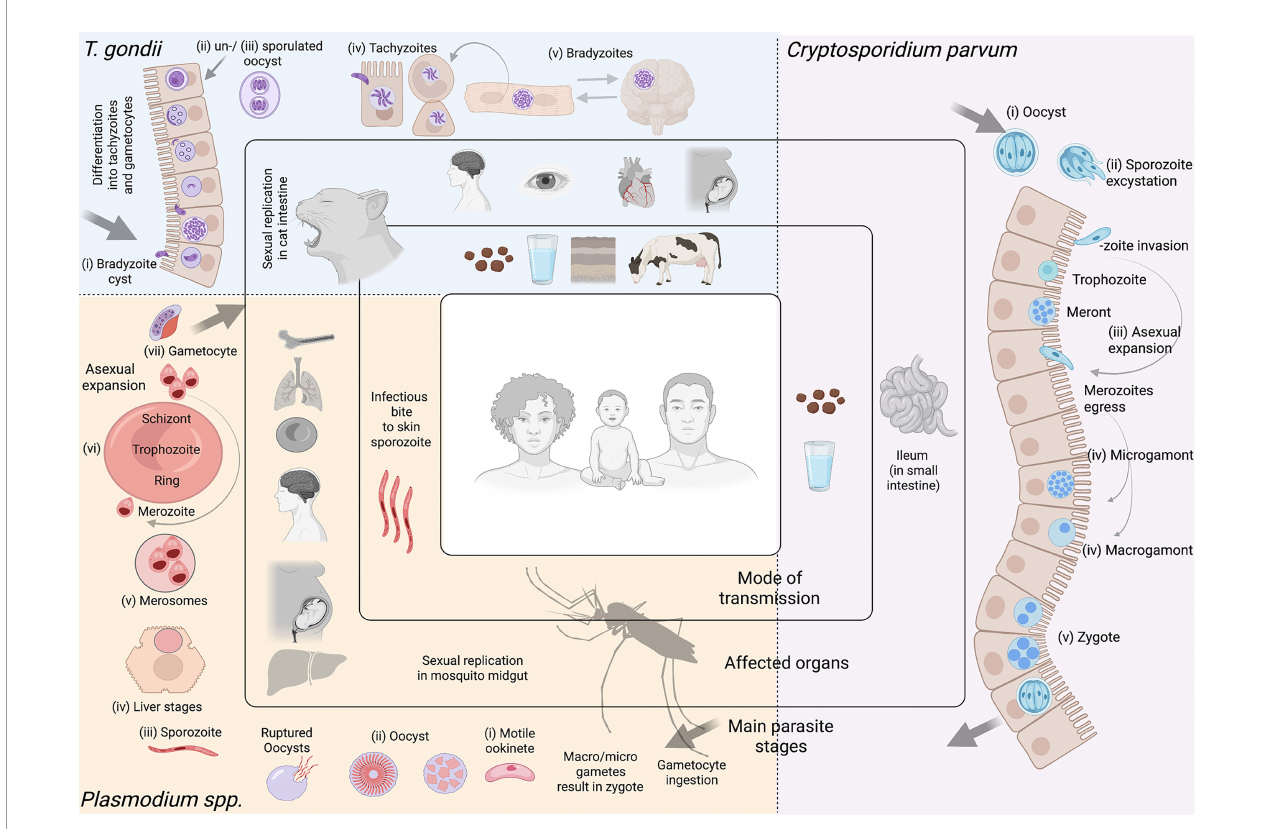
FIGURE 1 | Apicomplexan parasites. Most apicomplexan parasites have complex life cycles with several developmental stages that occur in different hosts and in different organs or tissues within the host. While advances have been made to culture many stages of these organisms in vitro , some are restricted to short-term culture. For others, only a limited number of stages can be sustained. Equally, not all stages are amenable to genetic modi fi cation. In this fi gure we summarize main features of Toxoplasma gondii, Cryptosporidium parvum , and Plasmodium spp. Toxoplasma gondii. (i) After ingesting bradyzoite cysts from an intermediate host, the sexual developmental cycle of T. gondii occurs in the gut of felines culminating in the shedding of large numbers of (ii) un-sporulated oocysts in their faeces. Within a few days, oocysts sporulate in the environment and become infective. (iii) Intermediate hosts can become infected by consuming contaminated soil, water or plants. Once consumed, oocysts transform into (iv) tachyzoites in the host ’ s gut. Dissemination of a tachyzoite infection and repeated rounds of cell infection, replication and egress (lytic cycle) leads to a systemic infection. Immune pressure triggers some tachyzoites to form tissue cysts that contain (v) bradyzoites. In humans, tissue cysts most commonly found in skeletal muscle, the heart, the eyes and the brain. T. gondii tachyzoites are able to cross the placenta from mother to fetus. Reactivation of an encysted infection can occur upon immune suppression and ingestion of bradyzoite cysts by another intermediate host can transmit the infection (v to iii). Among these T. gondii stages, tachyzoites and bradyzoites can be cultured in vitro in large amounts. Tachyzoites are amenable to genetic modi fi cation. Cryptosporidium parvum. (i) Sporulated oocysts are excreted by infected hosts through faeces and transmission to humans usually occurs via contaminated water. Following ingestion, the parasite undergoes excystation, whereby (ii) sporozoites are released, and invade the epithelial cells of the ileum. Here, C. parvum undergo (iii) 3 cycles of asexual expansion, followed by (iv) sexual commitment to either micro- or macro- gametes. Fertilization occurs and results in the generation of a (v) zygote, which continues onto a sporulated oocyst. Some oocysts continue to reinfect the host while others are excreted. Cryptosporidium does not complete its lifecycle in vitro without the use of complex organoid systems. Even so, generating large amounts is limited. The sporozoite is the only stage used for transfections; to generate transgenic oocysts, transfected sporozoites must immediately infect an animal model or organoid. Plasmodium spp. Female Anopheles mosquitoes are responsible for transmitting Plasmodium spp. Mosquitoes are the de fi nitive host, where Plasmodium undergoes sexual replication. This occurs in the mosquito ’ s midgut, where micro/macro-gametes generate zygotes which become motile (i) (ookinetes) and invade the midgut wall. Here they develop into (ii) oocysts. As oocysts mature, they rupture, releasing (iii) sporozoites which migrate to various locations in the mosquito, including its salivary glands. Following an infectious bite, sporozoites migrate from the dermis to the blood vasculature in humans. This allows them to reach the host liver, where they invade hepatocytes, and undergo a single round of (iv) asexual replication (by schizogony) resulting in the release of (v) merosomes fi lled with merozoites. Merosomes rupture in the blood circulation and release thousands of merozoites, which then infect red blood cells (iRBCs) and give rise to the erythrocytic stage of infection. Within RBCs, parasites develop into (vi) rings, trophozoites and schizonts. Mature schizonts rupture, releasing merozoites which invade other RBCs exponentially increasing the parasite mass. Some of these parasites will develop into sexual stages (called (vii) gametocytes). Mature asexual stages cause iRBC sequestration in organs including the brain, lungs, placenta, pancreas and adipose tissues, while sexual stages display preferential tropism to the bone marrow and other hematopoietic organs. Among these Plasmodium spp. stages, ookinetes, liver, asexual RBC, and sexual RBC stages can all be cultured in vitro in large amounts. Merosomes, rings, and schizonts are amenable to genetic modi fi cation. Note Large arrows in diagram refer to the completion of the cycle. Figure created with